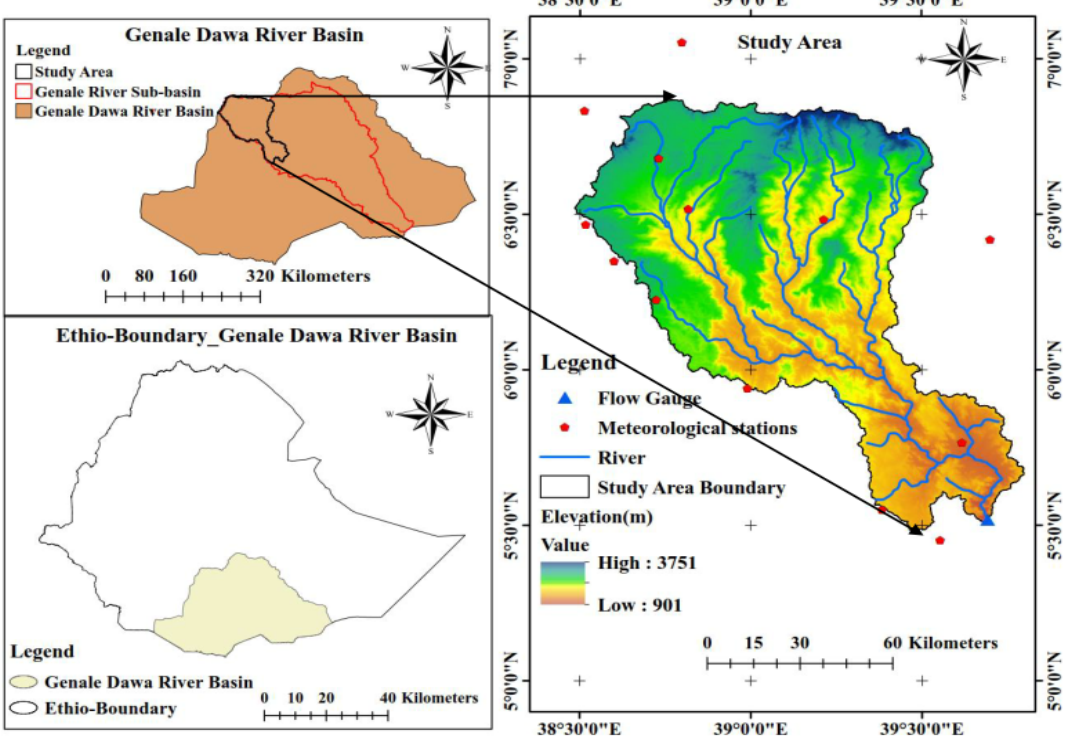
Figure 1. Location map of the upper Genale River